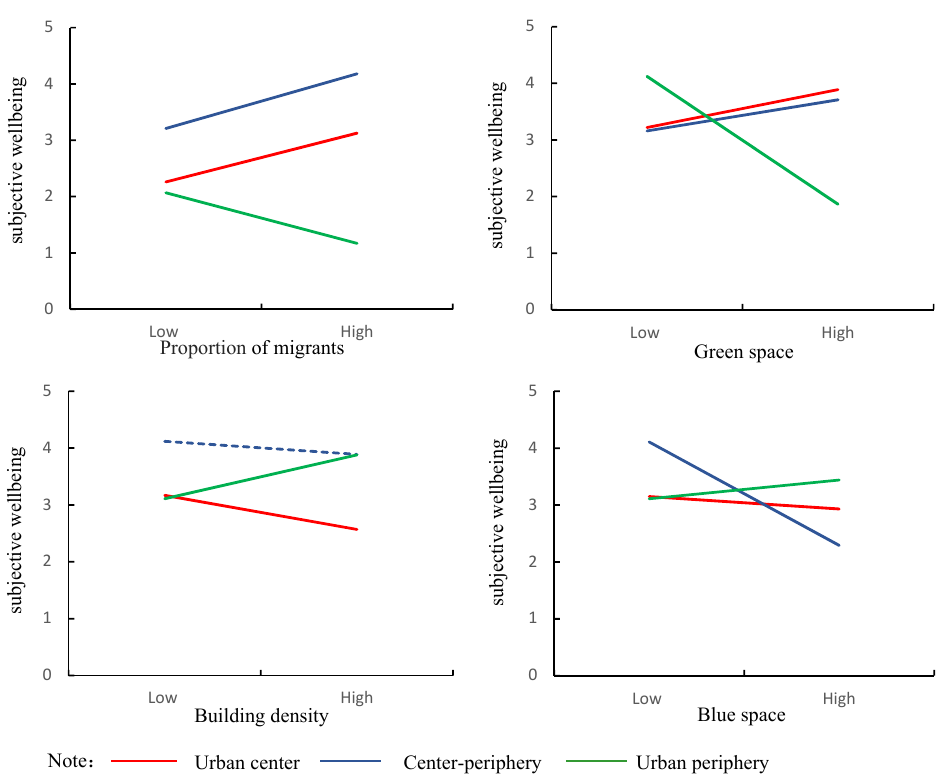
Figure 3. Moderating effect of residential location. Note: Solid lines represent statistical significance at the 90% confidence interval, while dashed lines do not.